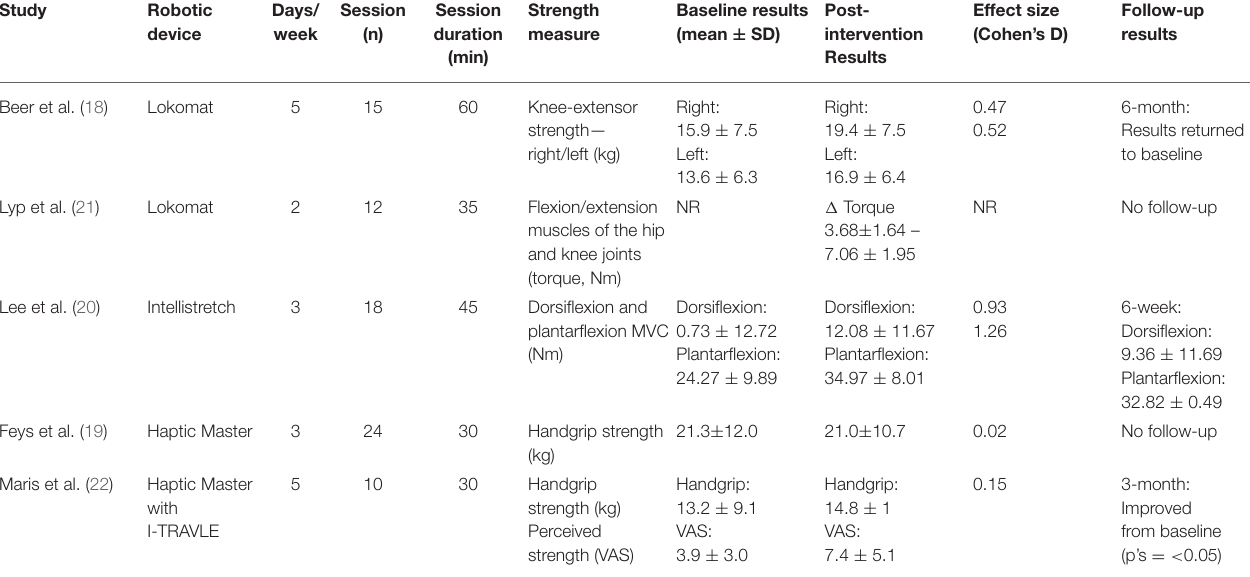
TABLE 4 | Detailed data extraction from included articles.